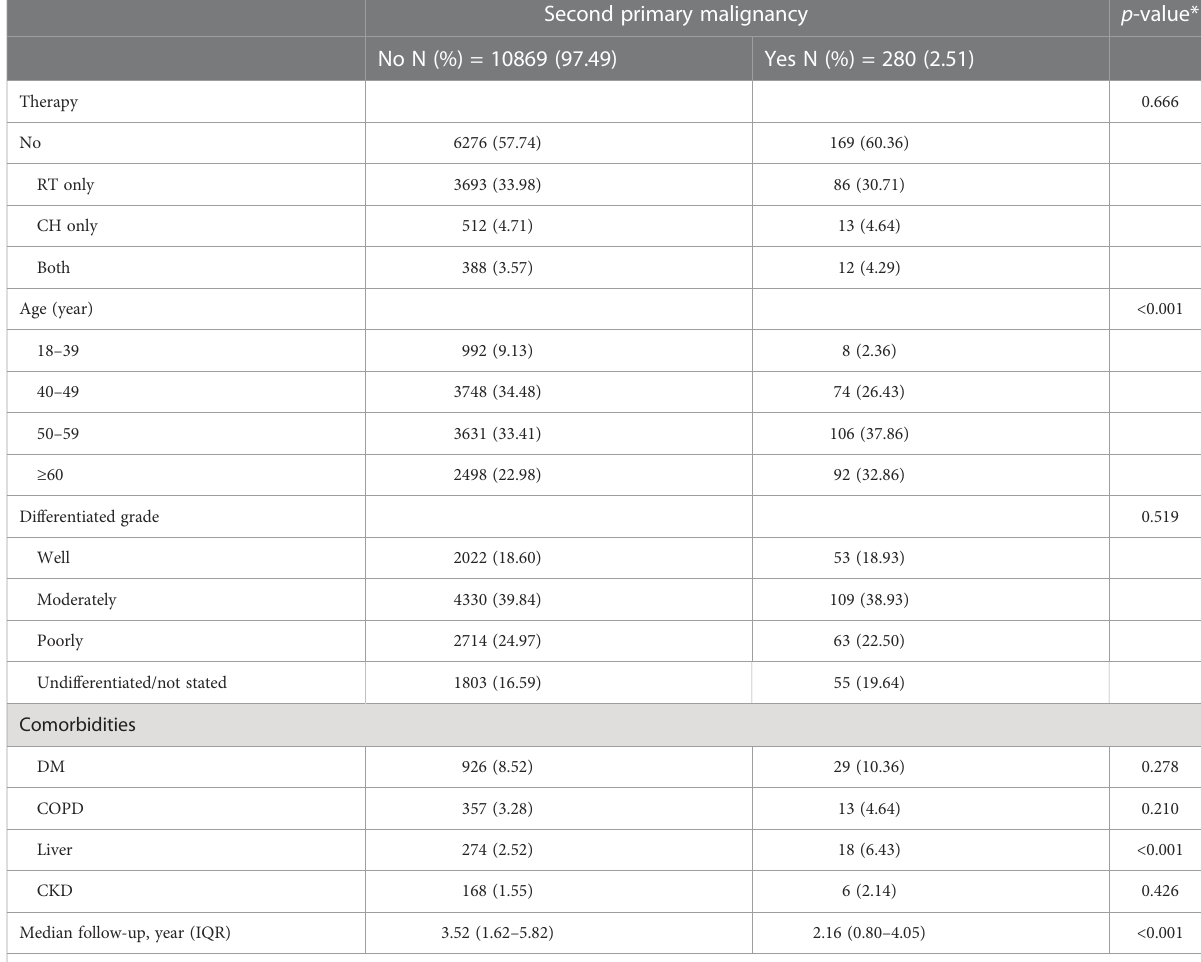
TABLE 4C Risk of second primary malignancies in patients with stage 0 breast cancer.